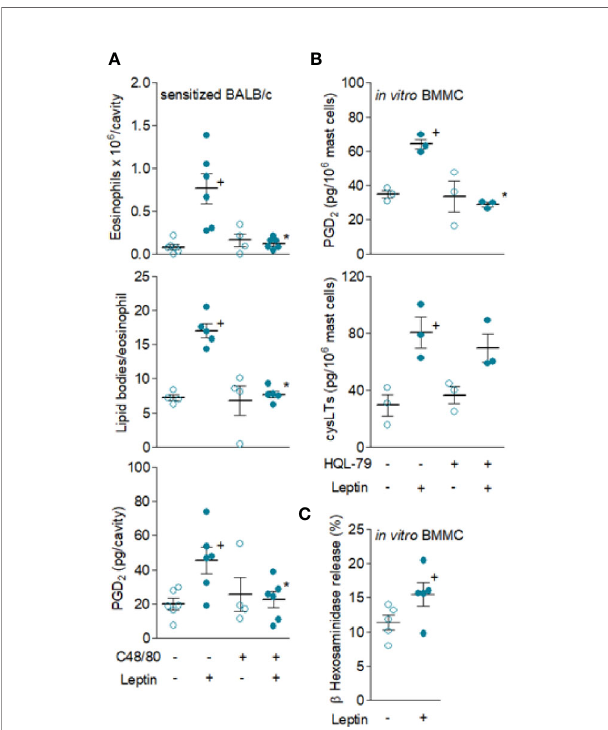
FIGURE 4 | Resident mast cells are leptin targets and are responsible for in vivo leptin-induced eosinophil migration and activation. In (A) , sensitized BALB/c mice were pre-treated with degranulating mast cell agent compound 48/80 and stimulated with leptin (1 mg/kg; i.pl.). Pleural fl uids were collected after 24 h of leptin stimulation. Analyses include pleural eosinophil counts evaluated in cells stained by May-Grünwald-Giemsa (upper panels), PGD 2 levels found in cell-free pleural fl uids measured by speci fi c EIA kit (middle panels) and numbers of cytoplasmic lipid bodies counted within osmium- stained pleural eosinophils (bottom panels). Values are expressed as the mean ± SEM (experiments were repeated at least once). + p < 0.05 compared to control group and * p < 0.05 compared to leptin-stimulated group. In (B, C) , mouse in vitro differentiated bone marrow-derived mast cells (BMMC) were pre-treated or not (as indicated) with HQL-79 for 30 min and then stimulated with 50 nM of leptin for 1 h. (B) shows PGD 2 and cysLTs levels found in BMMC supernatants quanti fi ed by speci fi c EIA kits. (C) shows BMMC degranulation by means of detection of extracellular activity of the intragranular enzyme b -hexosaminidase. Values are expressed as the mean ± SEM of different in vitro differentiation mast cells cultures (as indicated). + p < 0.05 compared to control